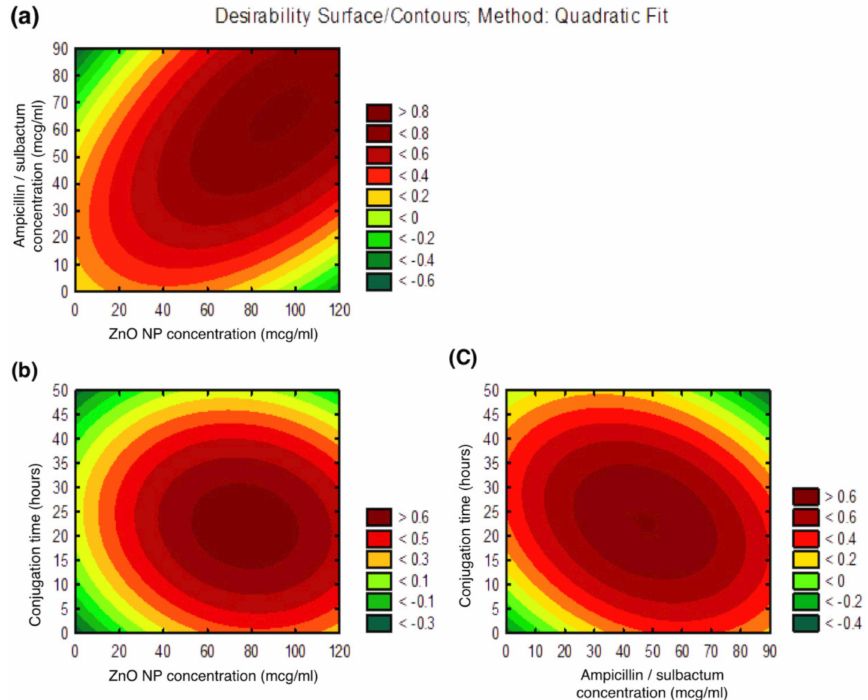
Figure 1. Response Surface Contour plots: ( a ) Contour plot of ZnO NP and Ampicillin / sulbactum concentration; ( b ) Contour plot of ZnO NP and conjugation time; ( c ) Contour plot of Ampicillin / sulbactum concentration and conjugation